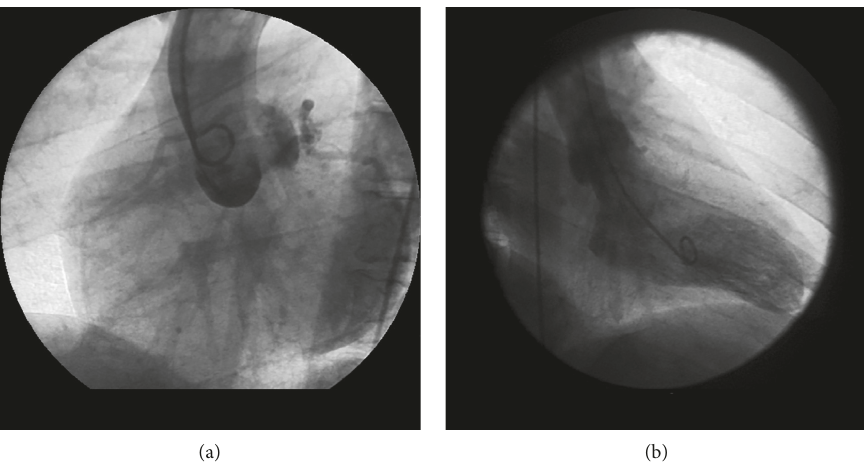
Figure 1: A case which was misdiagnosed as normal coronary arteries. However, with aortography in the left anterior oblique projection (a), it can be recognized that RCA originates from the LCS; with ventriculography in the right anterior oblique projection (b), a mark is seen on the location anterior to aorta, showing interarterial course.